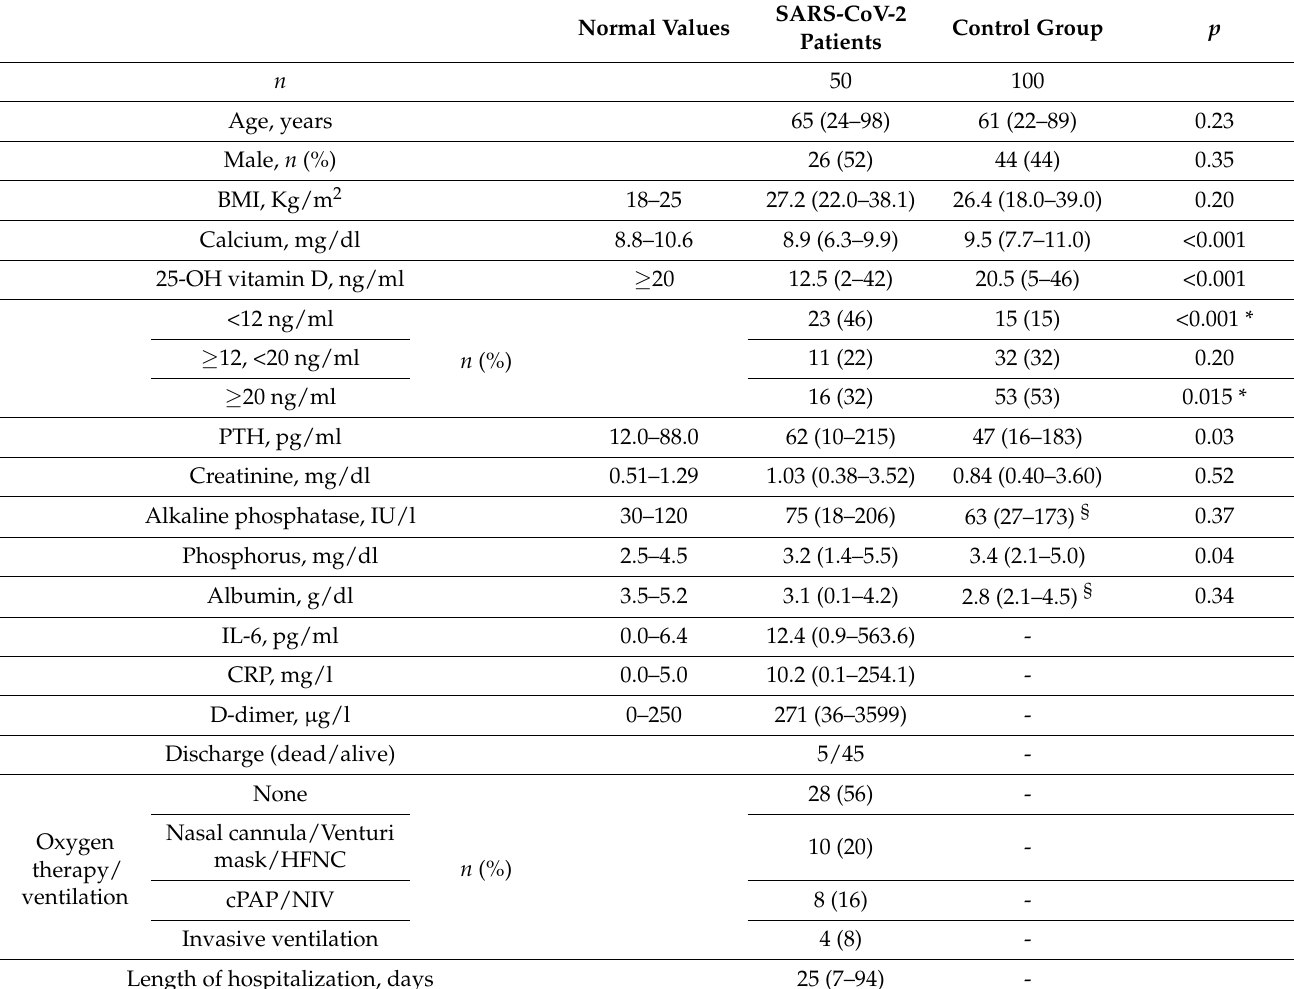
Table 1. Clinical and laboratory characteristics of